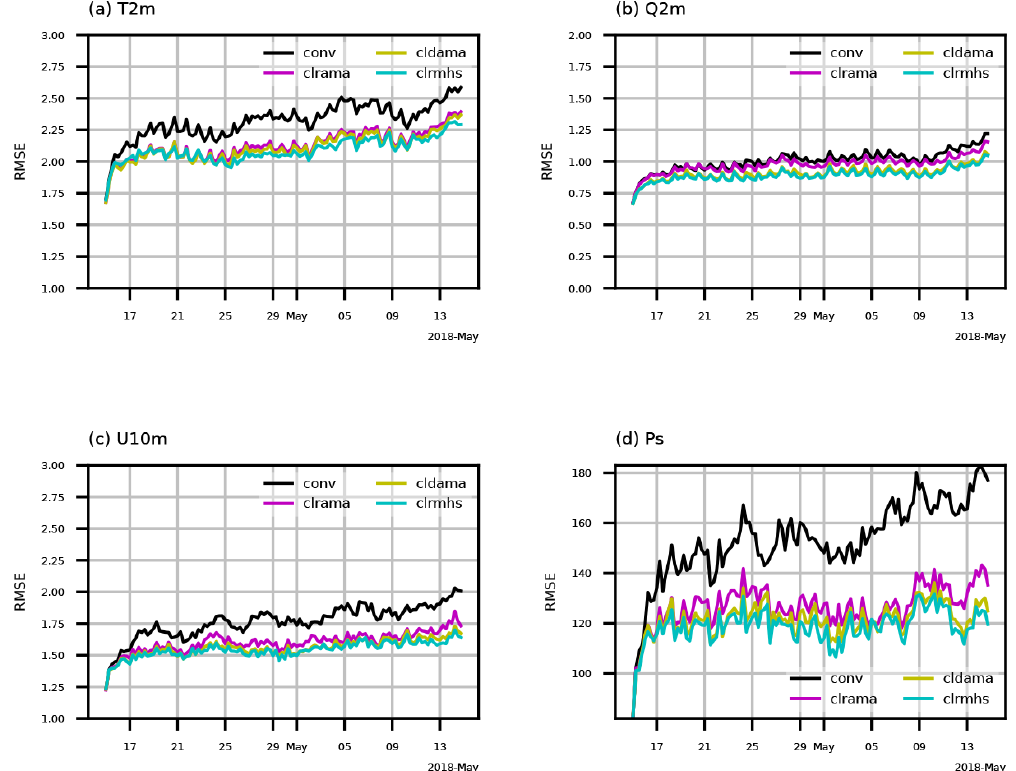
Figure 5. Time series (00:00UTC, 15 April–18:00UTC, 14 May 2018) of RMSE of cycling background with respect to GFS analyses for global (a) temperature (units: kelvin) and (b) specific humidity (units: gkg − 1 ) at 2m, (c) zonal wind component (units: ms − 1 ) at 10m, and (d) surface pressure (units: Pa) from the four